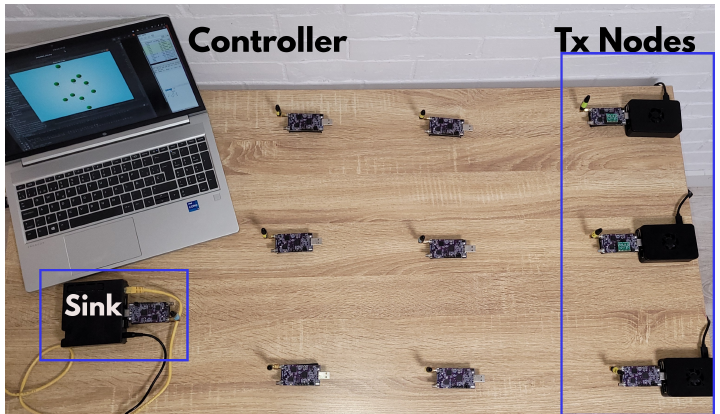
Figure 9. Testbed using OpenMote